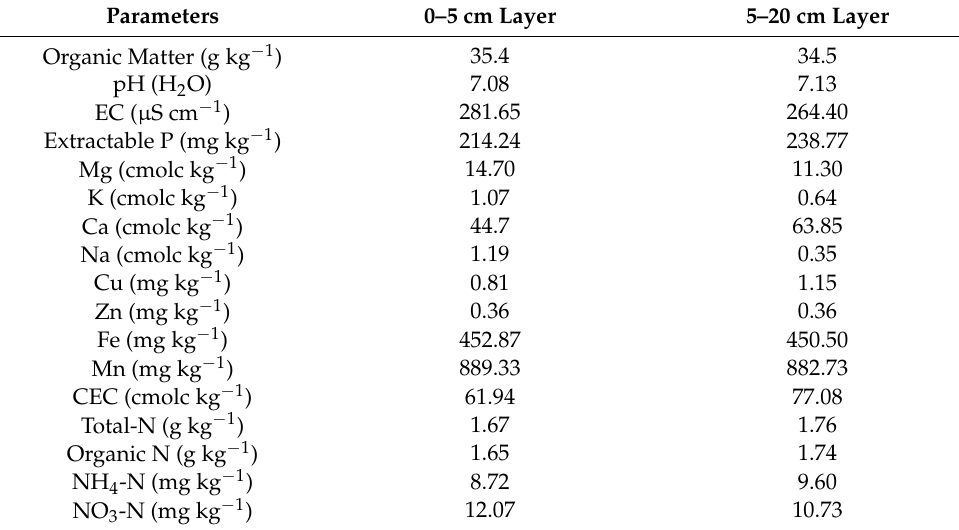
Table 4. Main characteristics of the soil used (Mean, n = 3).